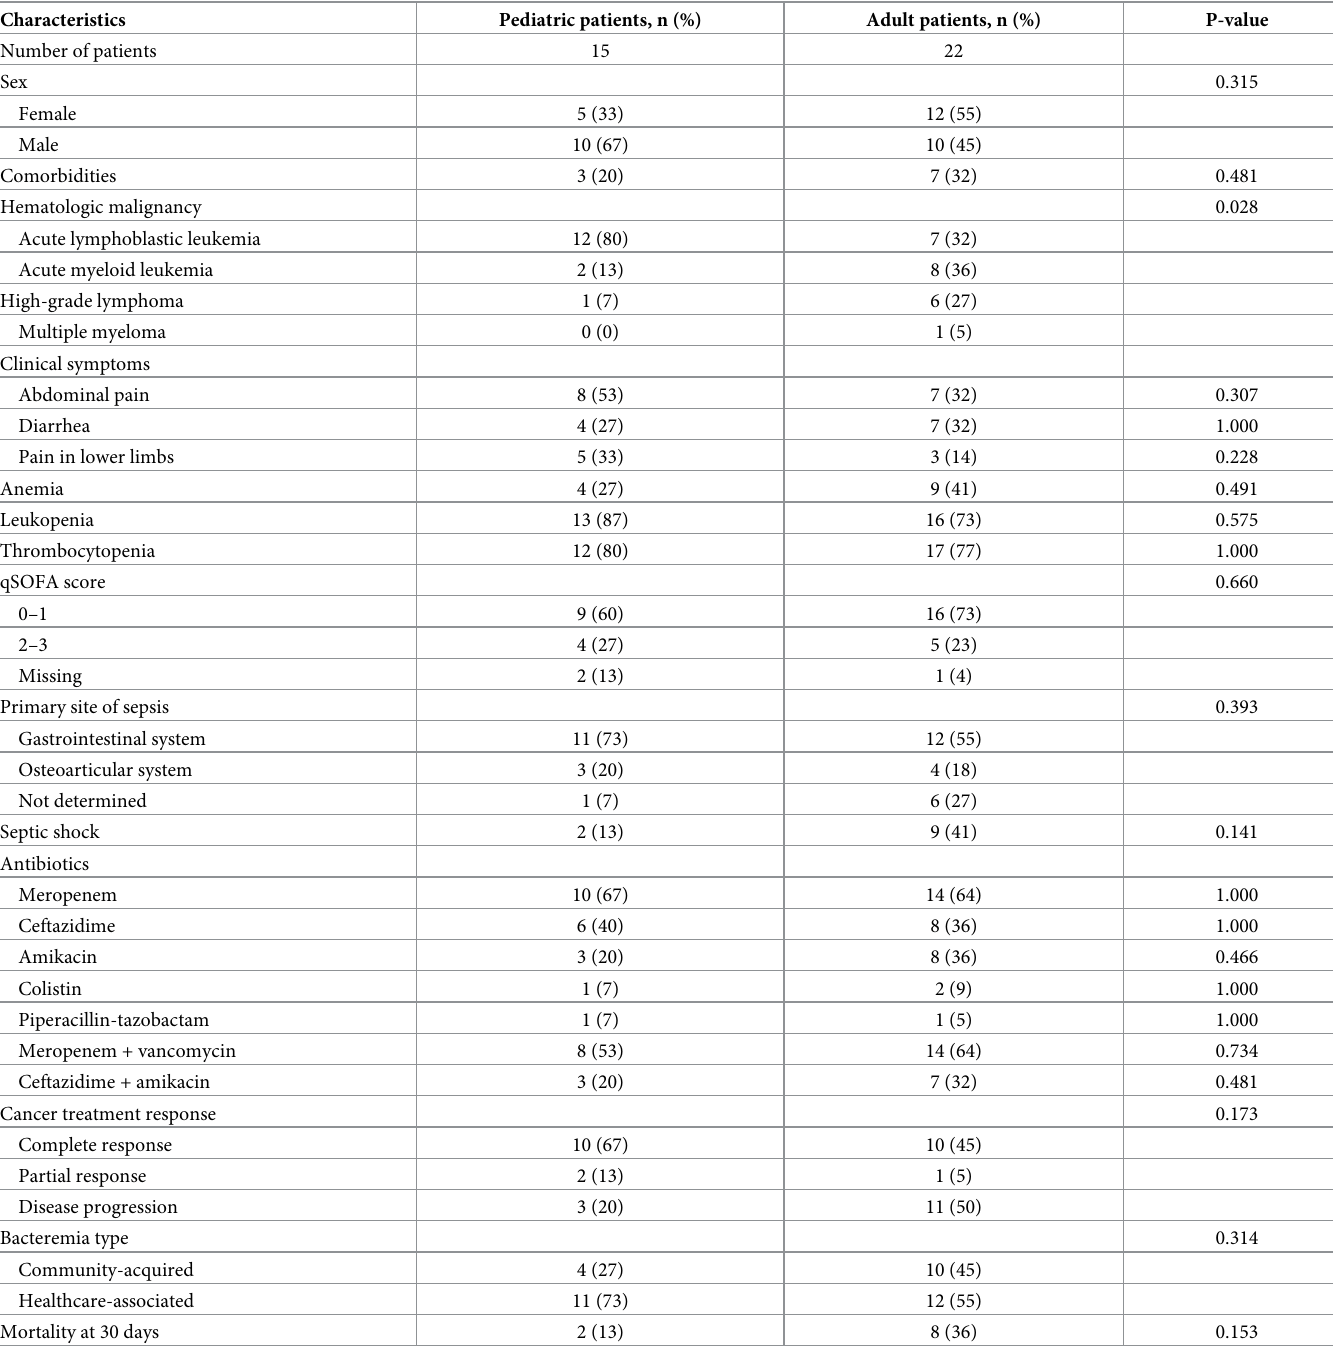
Table 2. Clinical characteristics of patients with hematological malignancies and Aeromonas sobria bacteremia according to age